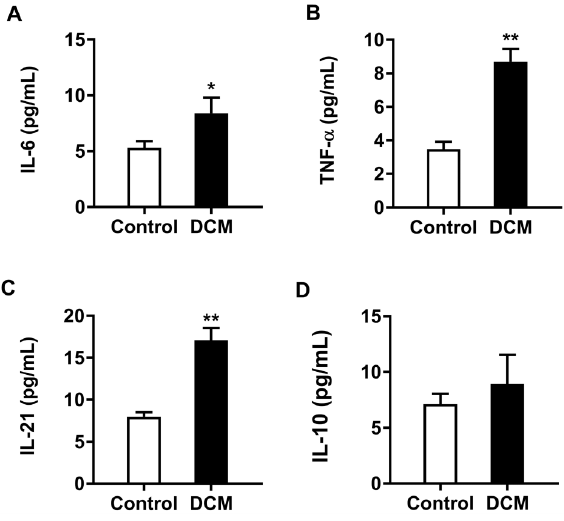
Figure 3. The mRNA expression levels of important molecules in peripheral blood mononuclear cells from dilated cardiomyopathy (DCM) patients and controls: Foxp3 ( A ), Bcl-6 ( B ), ICOS ( C ), and PD-1 ( D ). Data are reported as means ± SE (n=12). *P o 0.05, **P o 0.01 compared to the Control group ( t -test).